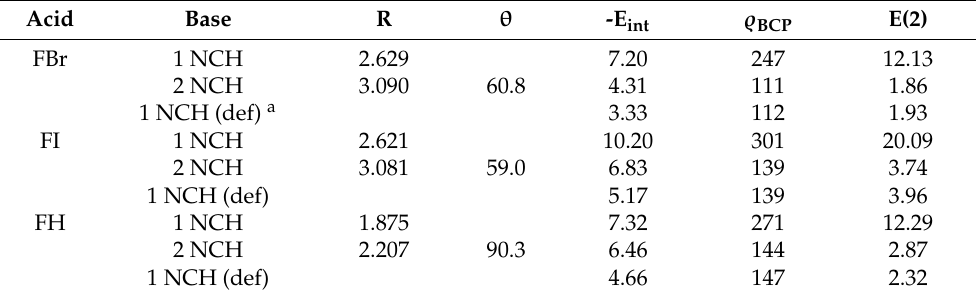
Table 2. Intermolecular distances (R, Å), interaction energies (kcal/mol), bond critical point density ( (cid:36) BCP , 10 − 4 au), and NBO N lp → σ *(FX) perturbation energy E(2) (kcal/mol) for complexes where one or two NCH bases share a single σ -hole on the acid, and θ (N ·· X ·· N) angle (degs) for bifurcated